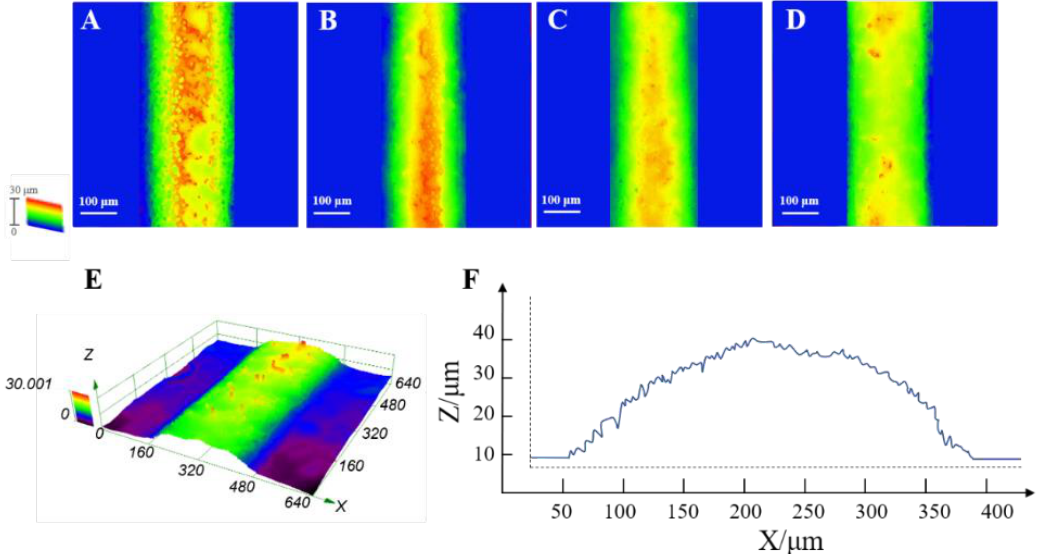
Figure 6. Topographical images captured by the confocal microscopy at 3.5 kV, 30 μl/min, and different Z : ( A ) 4 mm, ( B ) 6 mm, ( C ) 8 mm, ( D ) 10 mm. ( E ) The 3D topographical images and ( F ) cross-section of the PCL fiber fabricated when V = 3.5 kV, Q = 30 μl/min, and Z = 4 mm.